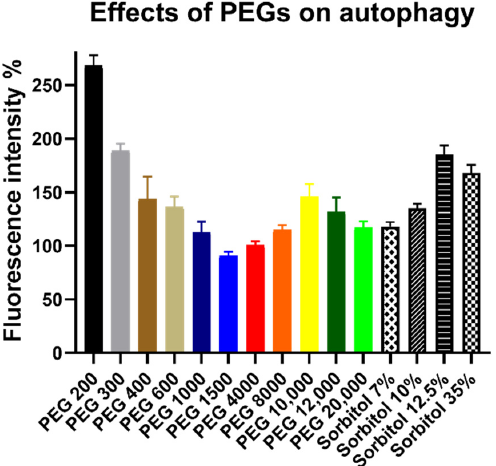
Figure 4. Effect of PEG and sorbitol solutions on the number of autophagosomes. Concentrations of all PEG solutions were 30 w / v % and volumes were 100 µ L. Fluorescence intensity is expressed as the percentage of the intensity of the untreated control cells. Columns represent the mean, ± SEM, n = 4, after the highest and lowest values were excluded. Fluorescence intensity of the samples (mean ± SEM): PEG 200: 268% ± 10%; PEG 300: 189% ± 6%; PEG 400: 144% ± 21%; PEG 600: 136% ± 10%; PEG 1000: 113% ± 10%; PEG 1500: 91% ± 4%; PEG 4000: 101% ± 4%; PEG 8000: 115% ± 4%; PEG 10,000: 146% ± 12%; PEG 12,000: 132% ± 13%; PEG 20,000: 117% ± 6%; Sorbitol 7 w / v %: 118% ± 4%; Sorbitol 10 w / v %: 135% ± 5%; Sorbitol 12.5 w / v %: 185% ± 8%; and Sorbitol 35 w / v %: 168% ± 7%. 3.4. Flow Cytometry Results As sorbitol solutions had only limited impact on cells, we excluded them from further experiments. For flow cytometry, Caco-2 cells were stained with propidium iodide and labelled with annexin V to distinguish between necrotic and early apoptotic cells. Figure 5 shows the distribution of gated cells. The proportion of unstained, living cells (PI − AV − ) increases with molecular weight. For low molecular weight PEGs, necrotic cells (PI+ AV+) are the dominant for dead cells and but with the increase in molecular weight the ratio of early apoptotic cells (PI − AV+) increases. Figure 5. Proportion of living, dead, and apoptotic Caco-2 cells, measured by flow cytometry, treated with 1 mL of 30 w / v % solutions of PEGs, stained with propidium iodide (PI) and annexin V (AV). Each point represents the mean of triplicates. Data represented as percentage distribution of